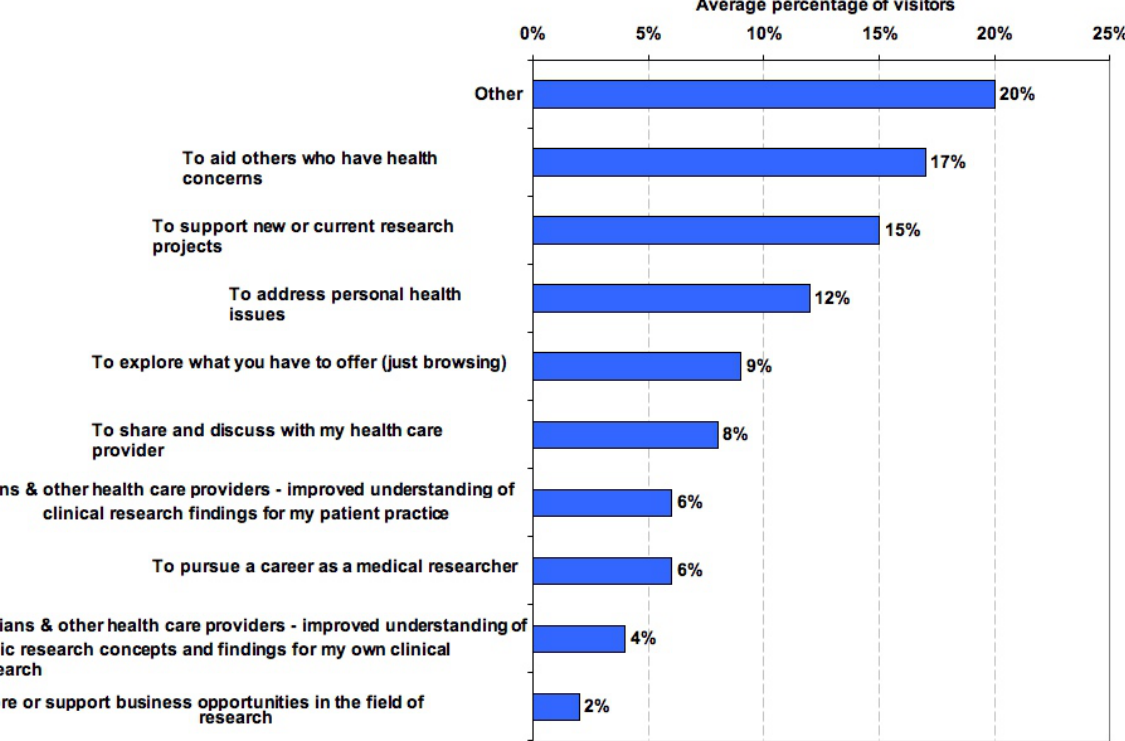
Figure 3. Intended use of information found on website as reported by site visitors (Note: Percentage of visitors indicating each intended use, averaged across all 35 reporting websites; percentages in this case add up to 100% because a standard question with the same response choices was used on all participating sites.) (Method: ForeSee Results Inc. standard custom